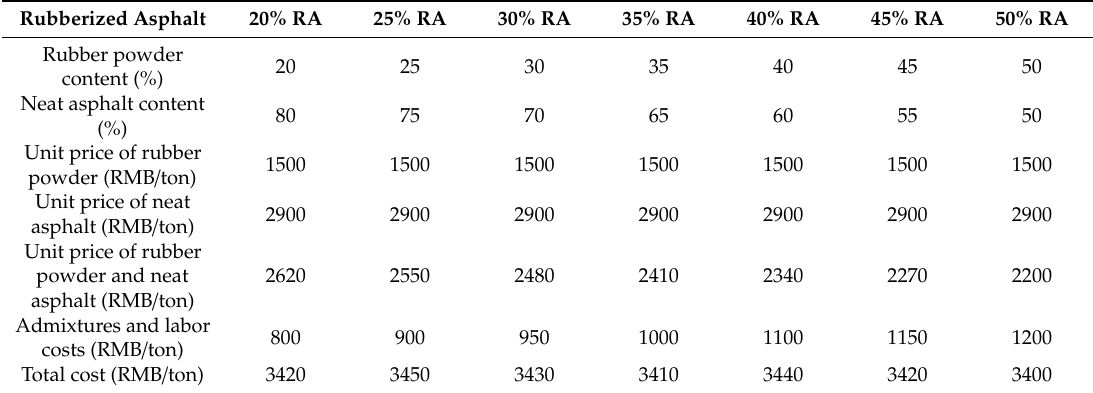
Table 4. Economic analysis of rubberized